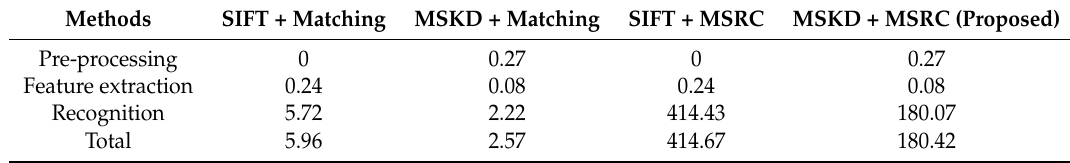
Table 2. Comparison between the execution time (s) of different methods on ISAR images